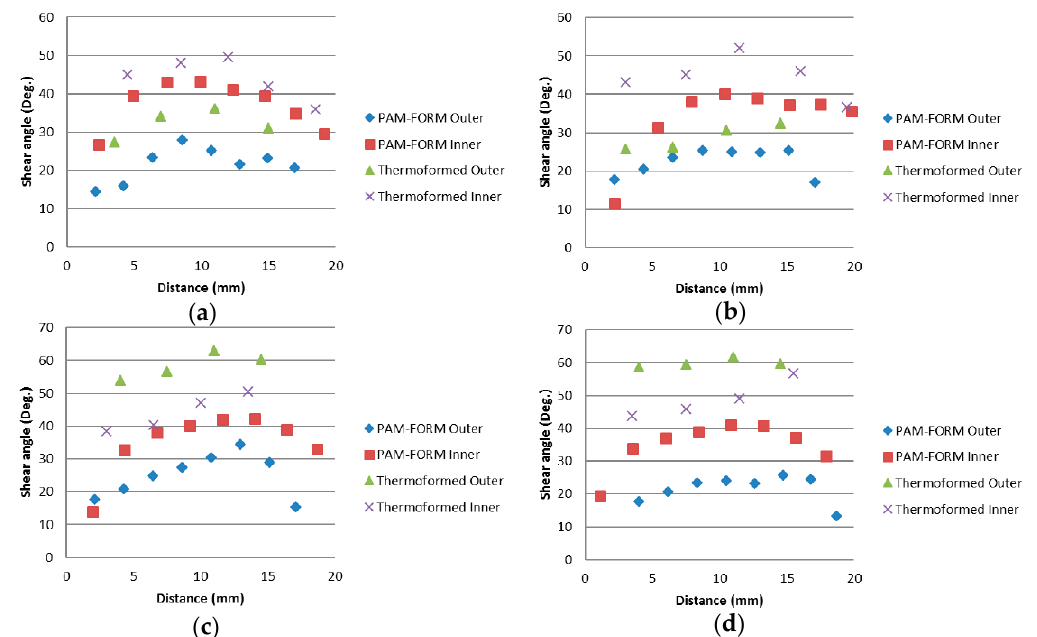
Figure 11. Comparison between the experimental and simulation results for the shear angle at each corner. ( a ) corner 1; ( b ) corner 2; ( c ) corner 3; ( d ) corner 4 as illustrated in Figure